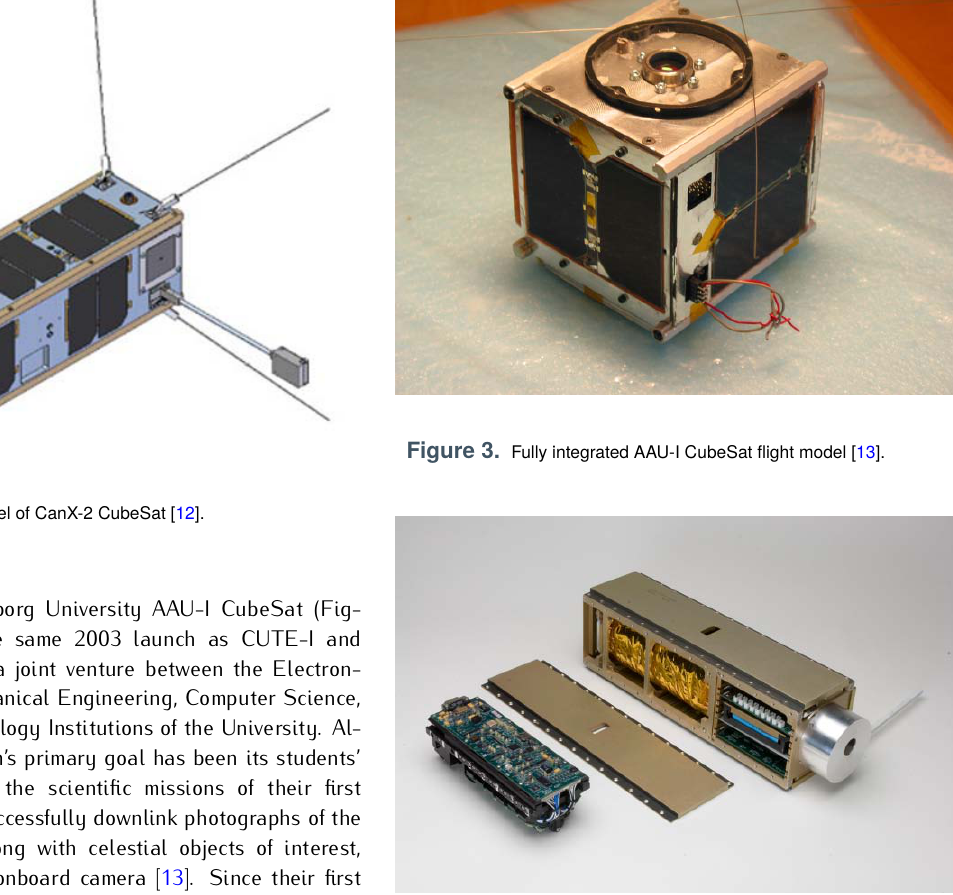
Figure 4. GeneSat-1 payload assembly